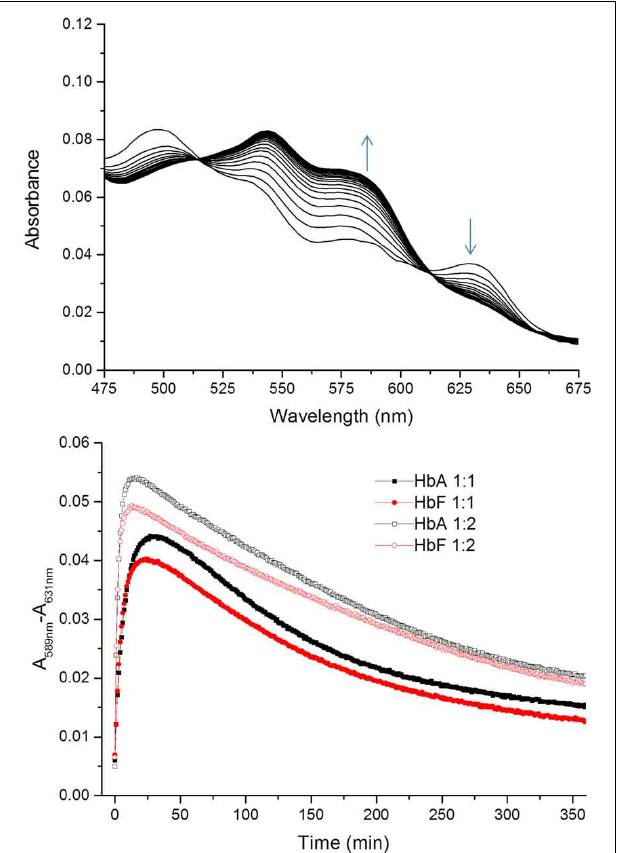
FIGURE 4 | Time courses for the reaction between ferric Hb and hydrogen peroxide. The spectra of the reactions were recorded every 1min for 360min within the 450–700nm region. The upper figure shows a typical spectrum during the first 20min of the reaction between ferric HbF and hydrogen peroxide. The appearance of ferryl Hb species (589nm) and the decrease of ferric species (631nm) are indicated with arrows. The lower part illustrates the differences in absorbance at 589–631nm over time for the reaction between ferric Hb and hydrogen peroxide. Closed symbols represent the reaction when the Hb:hydrogen ratio is 1:1 and open symbols 1:2. Black and red represent the reactions of HbA and HbF, respectively.